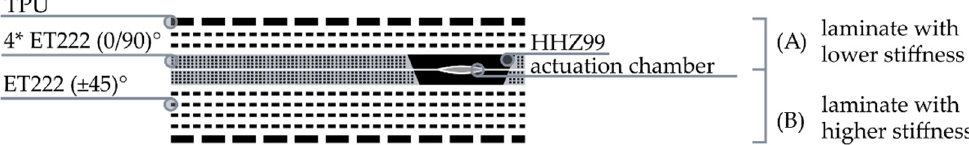
Figure 11. Schematic sketch of laminate set-up with stiffened flaps due to the substitution of HHZ99 by four layers ET222 (fiber orientation 0/90°) (HHZ99 layer on laminate side ( A ) with lower stiffness 5 cm wider than on laminate side ( B ) with higher stiffness).